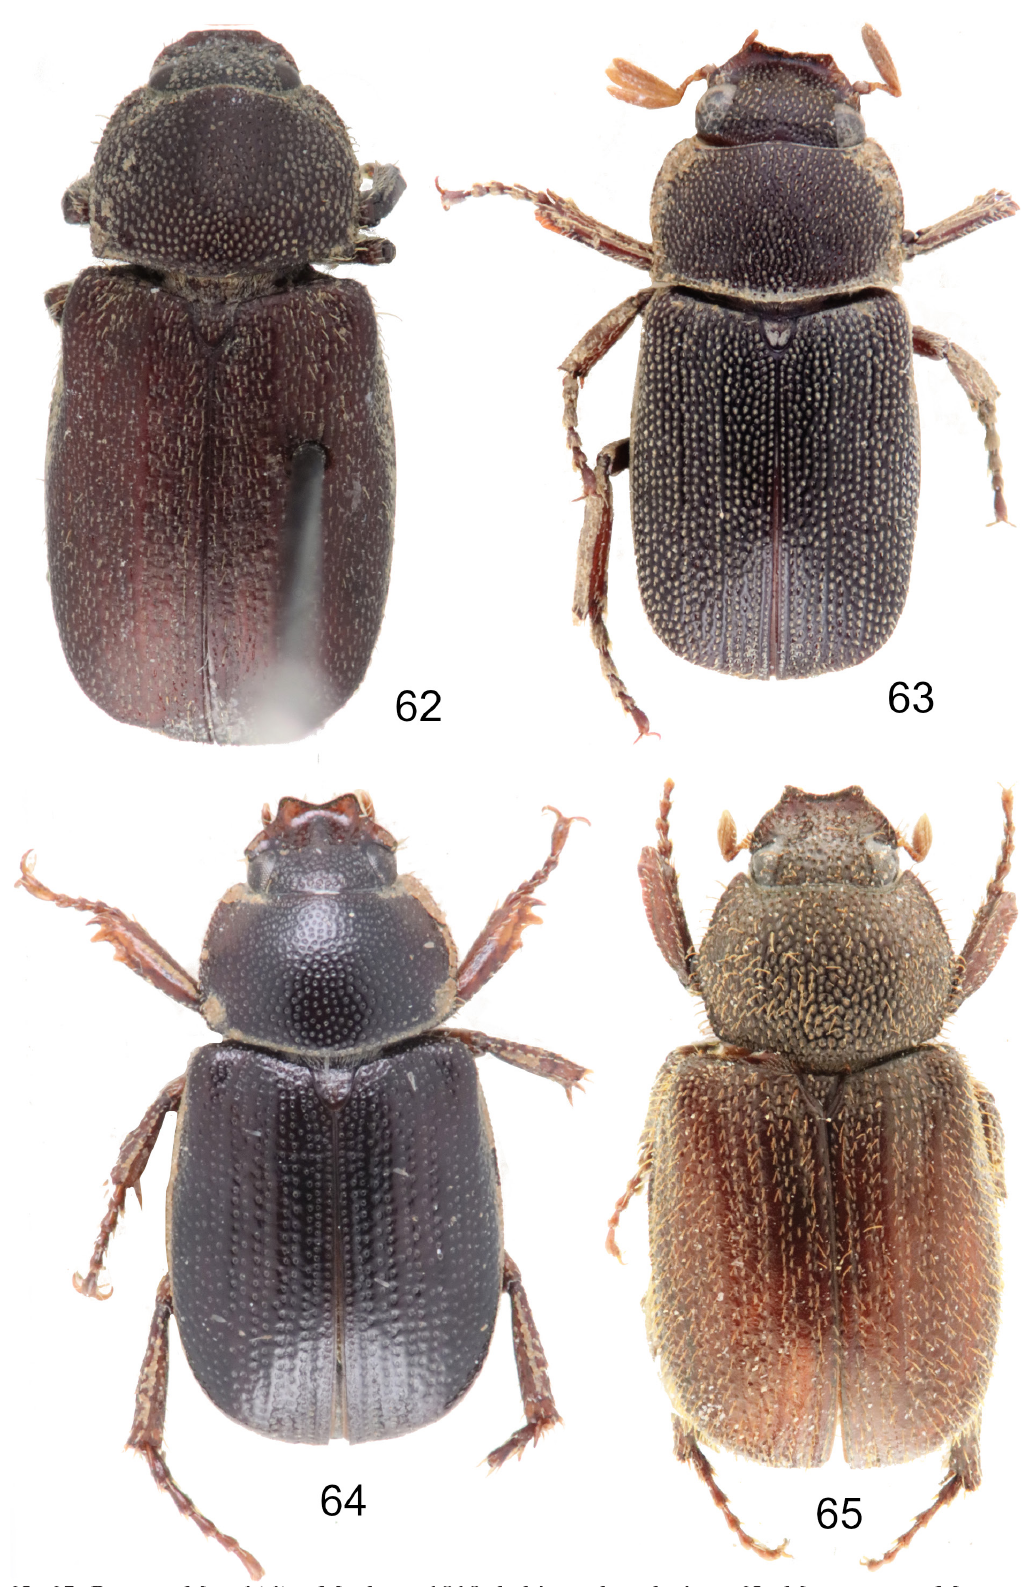
Figs 62–65. Papuan Maechidius Macleay, 1819, habitus, dorsal view. 62 . M. papuanus Moser, 1926, lectotype, ♀ (ZMHB). 63 . M. muticus Arrow, 1941, syntype, ♂ (BMNH). 64 . M. nanus Arrow, 1941, syntype, ♂ (BMNH). 65 . M. nepenthephilus sp. nov., holotype, ♂ (NME). Not to